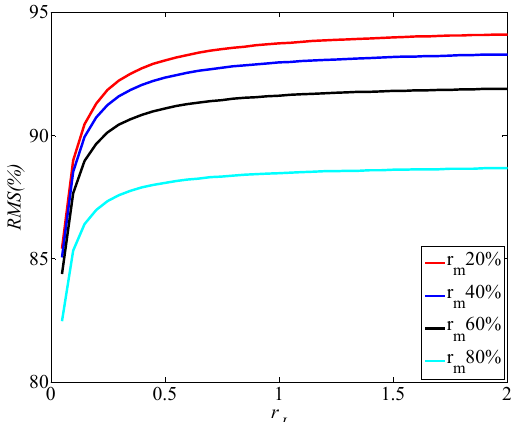
ff ect of rotation inertia and mass on control e ff ectiveness: curves of RMS . Figure 4. Effect of rotation inertia and mass on control effectiveness: curves of RMS . Figure 4. E